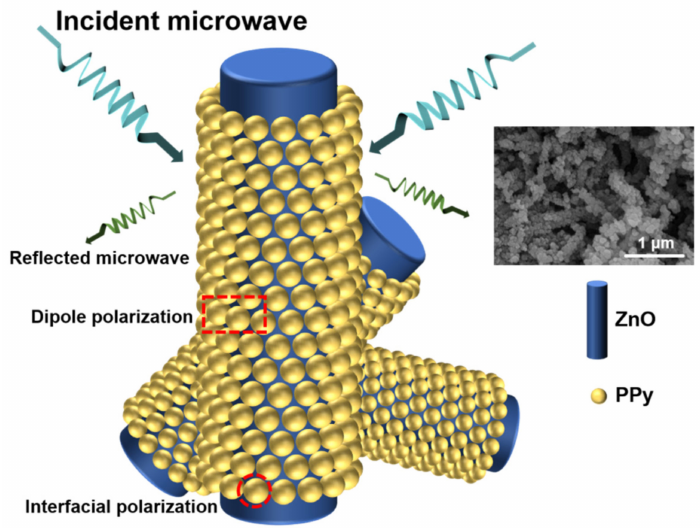
Figure 9. Microwave absorption mechanism of ZnO/PPy